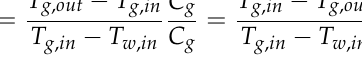
Figure 9. Power output vs efficiency. The dashed curve shows the efficiency with respect to the net heat input to the thermoelectric legs and the solid curve shows the efficiency with respect to the overall heat input to the CHP system. In this particular case, the maximum power output was 355 W/m 2 , with a hot gas flow rate of 0.36 kg/s and water flow rate of 0.05 kg/s.